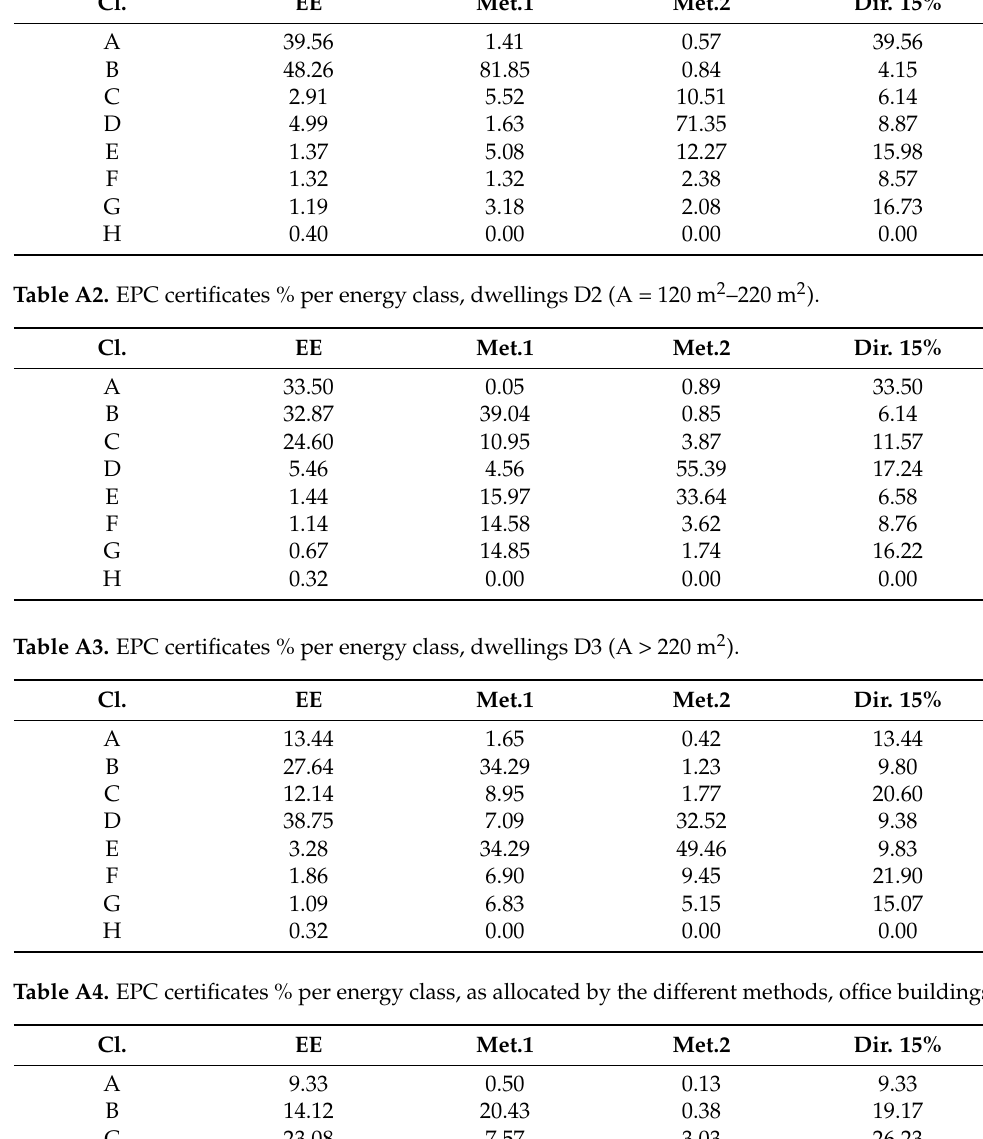
Table A1. EPC certificates % per energy class, dwellings D1 (A < 120 m 2 ). Cl.